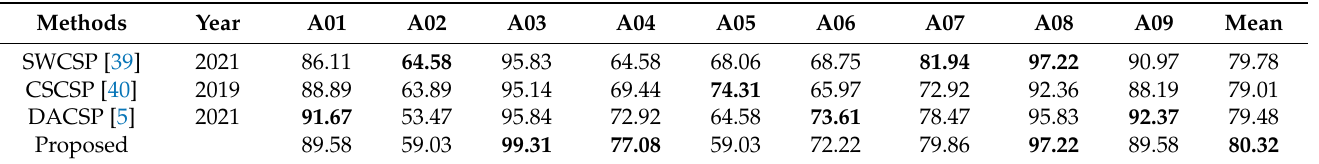
Table 4. Comparison of accuracies (%) of the proposed method and three existing methods on dataset